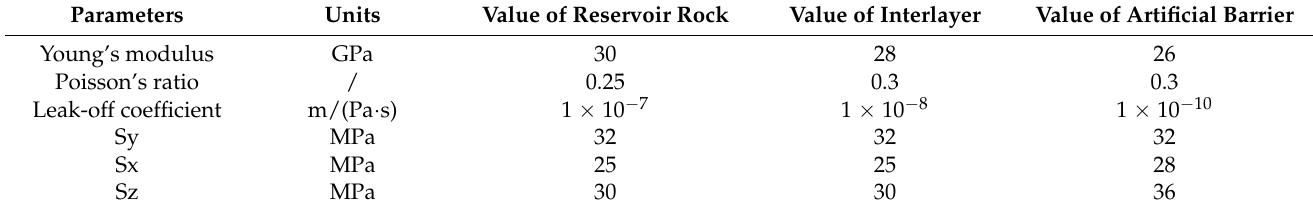
Table 4. The rock mechanics parameters of the stratum.